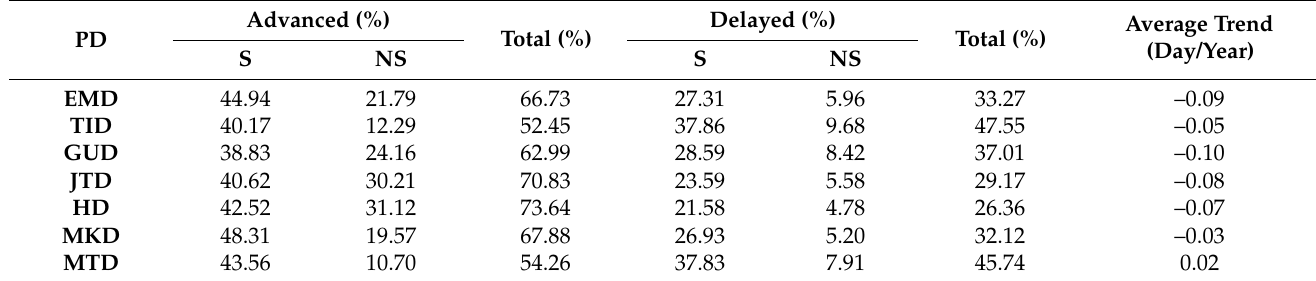
Table 2. Proportion of advance and delay of different phenological dates.